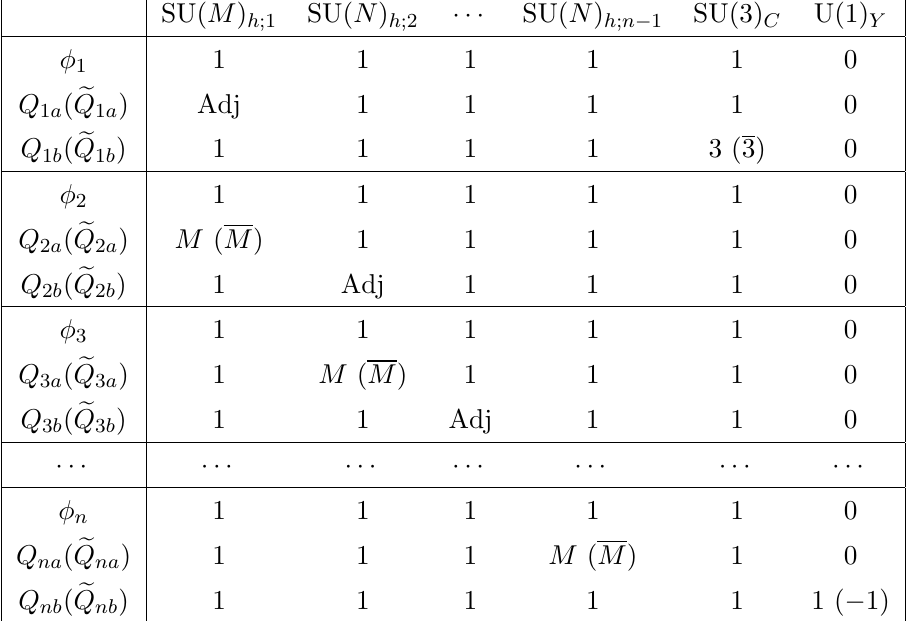
Table 3 . Particle content of a con(cid:12)nement tower